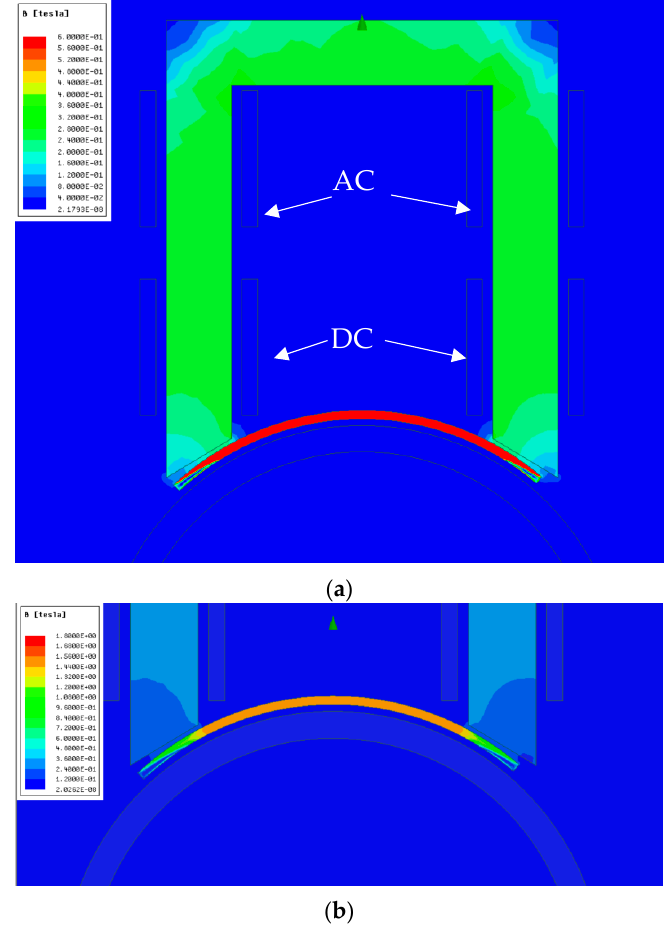
Figure 13. Magnetostrictive transducer based on the use of a magnetic core. Simulation performed at 0 Hz and 5 A. Maximum magnetic field in the core ( a ) and permendur ( b ).